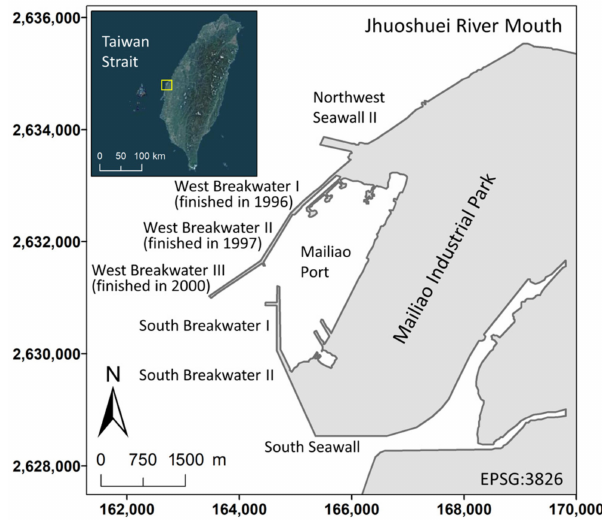
Figure 1. Mailiao Port in Central Taiwan.